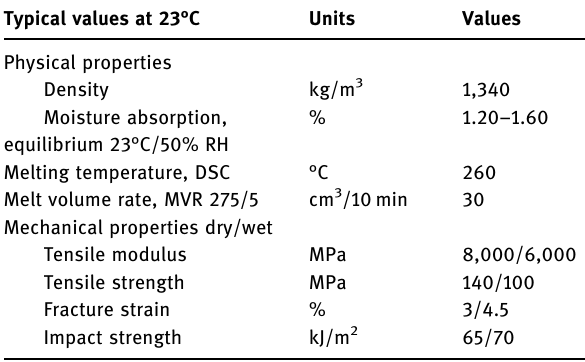
Table 1: Properties of the PA66 - GF25 FR ( RP ) composite Typical values at 23°C